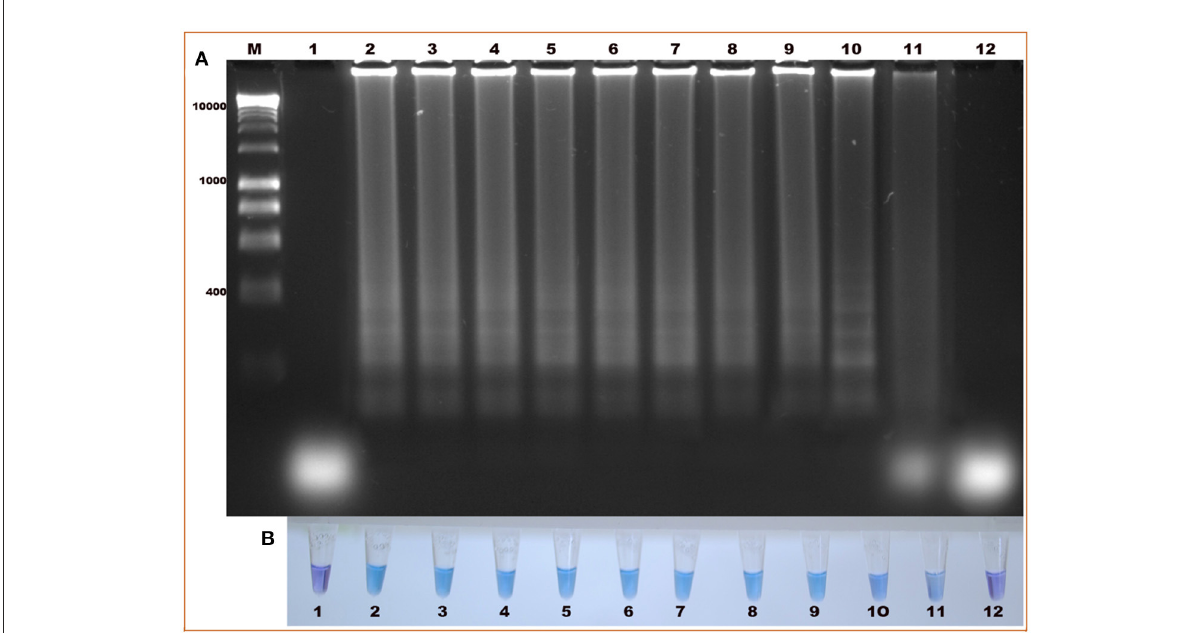
FIGURE5 Evaluation of the diagnostic sensitivity of the LAMP technique, for the detection of the ama-1 gene of B. bigemina . (A) Electrophoresis in 1.2% agarose gel, stained with red gel. (B) Colorimetric test with hydroxynaphthol blue. Lanes: M) Molecular size marker in bp; (1) Negative control, (2)